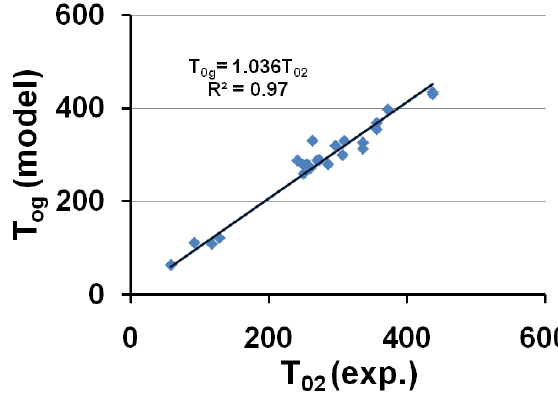
; T  1.036 T g 0g 02